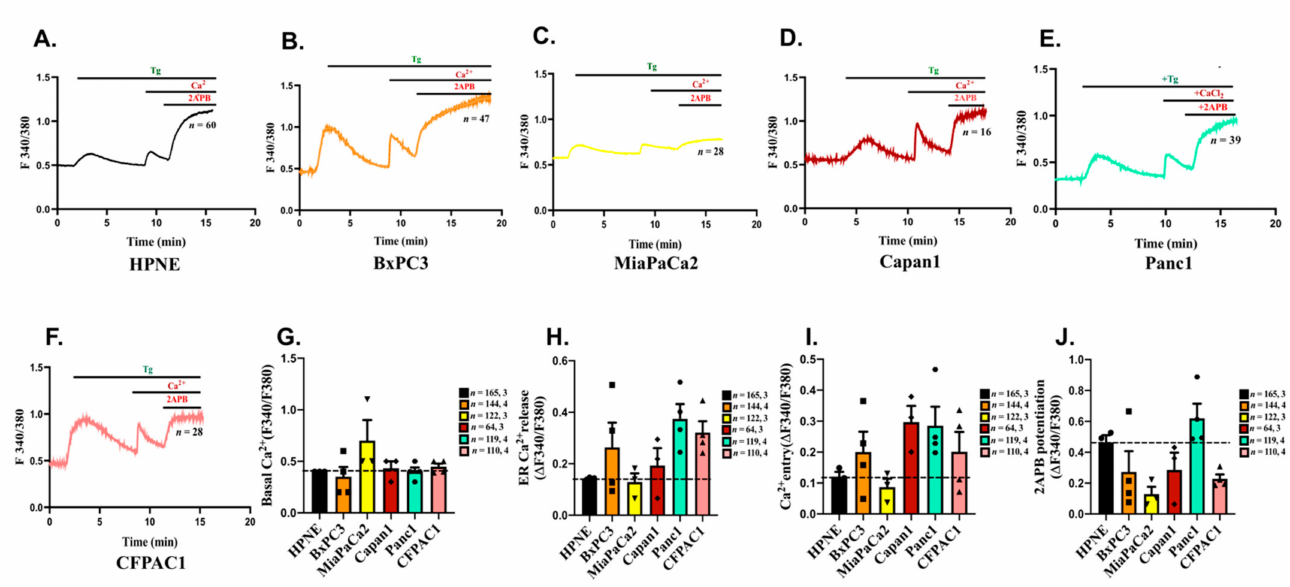
Figure 2. Characterization of SOCE in a battery of Pancreatic cancer cell lines. ( A – F ) Representative Ca 2+ imaging traces of HPNE, BxPC3, MiaPaCa2, Capan1, Panc1 and CFPAC1 cells where “n” denotes the number of cells in that particular trace. ( G ) Quantitation of basal Ca 2+ levels across different cell lines. ( H ) The amplitude of ER Ca 2+ release was calculated from a number of experiments and data are presented in dot plot graphs. ( I ) The extent of SOCE was calculated from several experiments and data are presented in dot plot graphs. ( J ) 2-APB induced potentiation of Orai3 mediated SOCE was calculated from several experiments and data are presented in dot plot graphs. The total number of cells imaged in ( G – J ) are reported as “ n = x , y ” where “ x ” denotes total number of cells imaged and “ y ” denotes number of traces